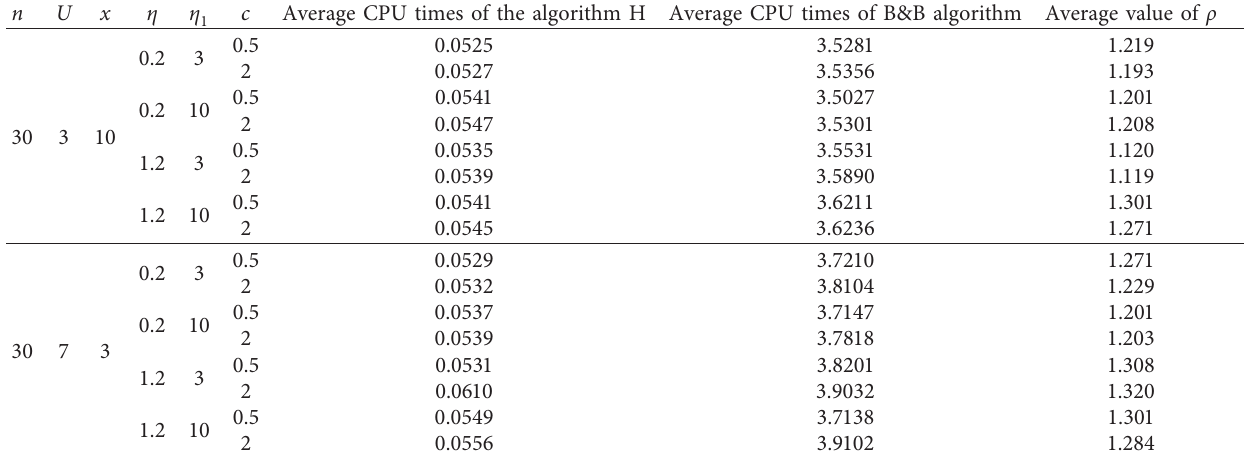
Table 7: The results of the algorithm H and branch-and-bound (B&B) algorithm for ( P